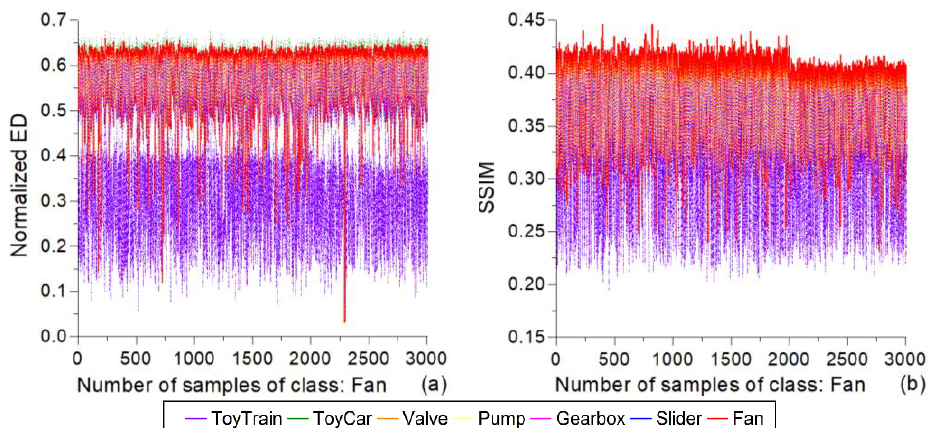
Figure 6. Mean per-sample line plots for both intraclass (solid line) and interclass similarity (dashed lines) for the full dataset and fan samples: ( a ) normalized ED and ( b ) SSIM (legend is the same for all plots).